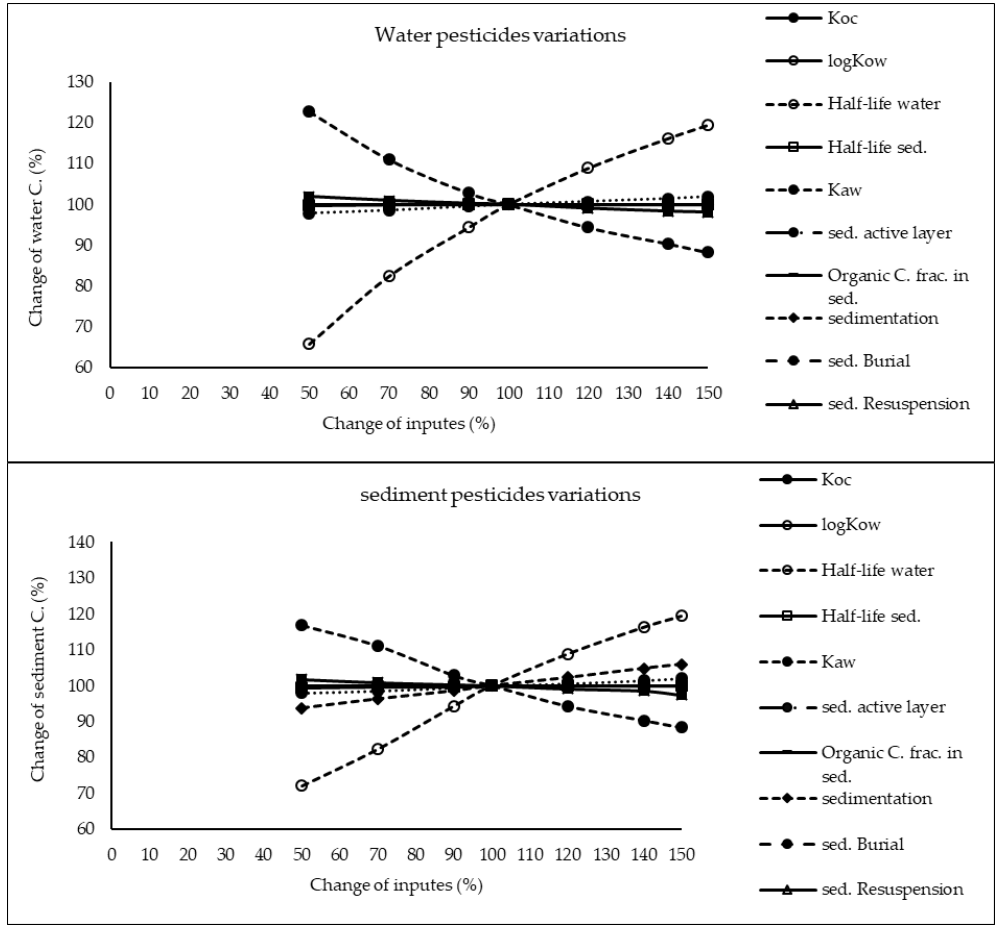
Figure 4. Results of the sensitivity analysis for endosulfan–sulfate in Lake Naivasha.